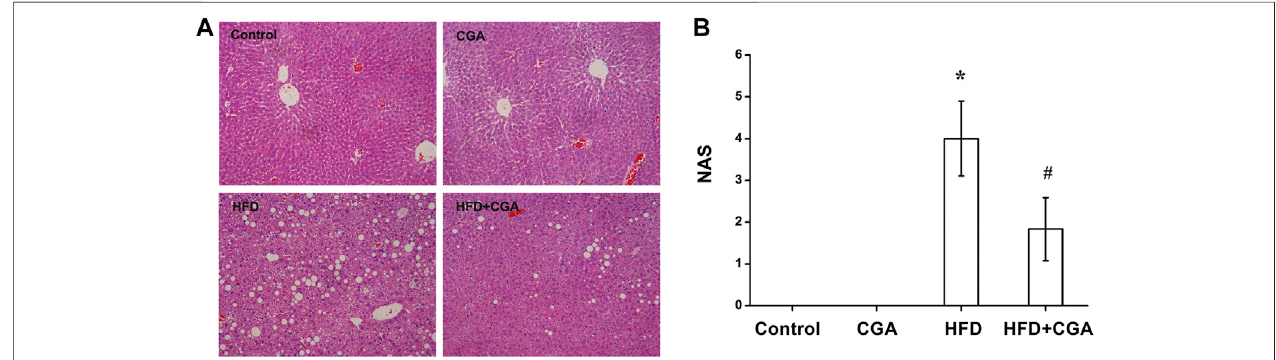
FIGURE 1 | Effect of CGA on liver tissue pathology. (A) Hematoxylin-eosin staining for liver sections (200 × ). (B) NAS in four groups. Data are presented as the mean ± SD. * p < 0.05 as compared with the control group; # p < 0.05 as compared with the HFD group.